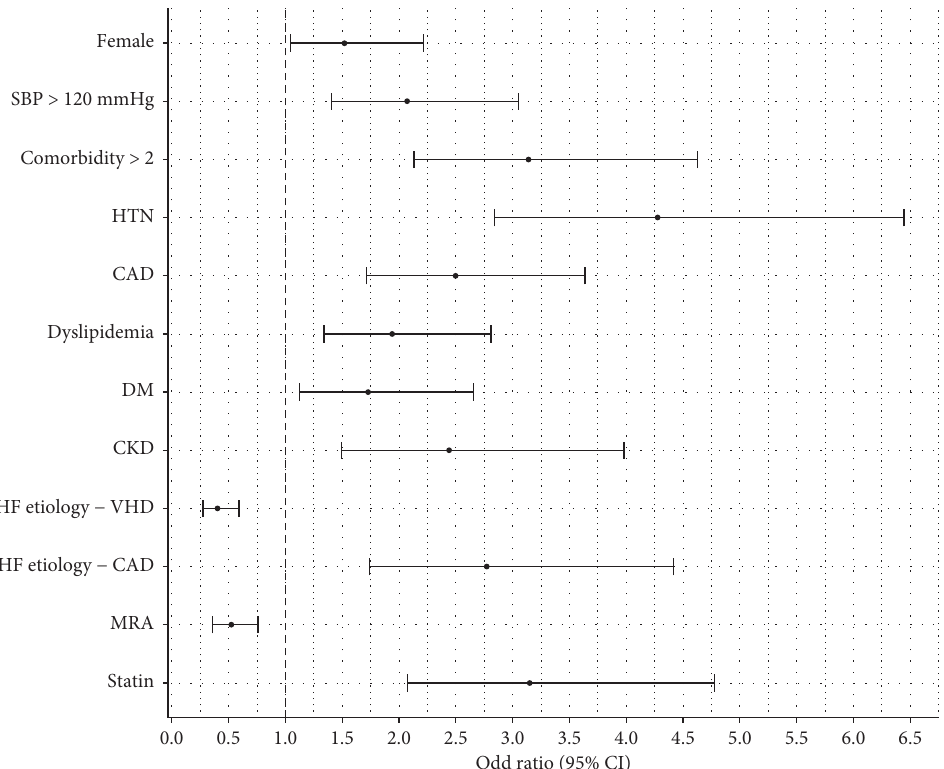
Figure 2: Forest plot depicting association between patient characteristics, comorbidity, treatment, and odds of being age ≥ 65 versus < 65. CAD: coronary artery disease; HTN: hypertension; AF: atrial fibrillation/flutter; DM: diabetes mellitus; CKD: chronic kidney disease; VHD: valvular heart disease; SBP: systolic blood pressure; MRA: mineralocorticoid antagonist.